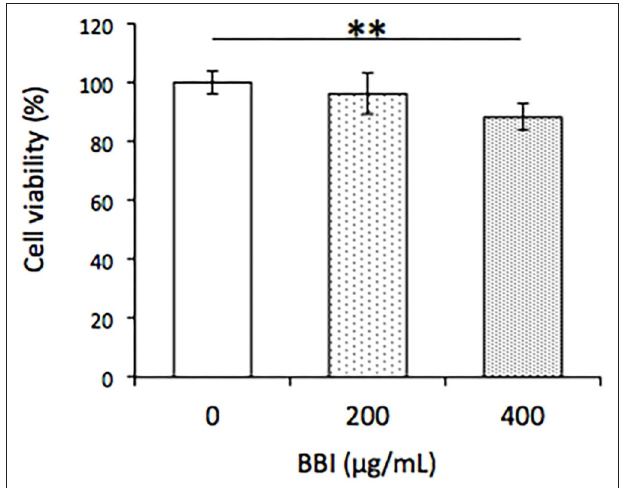
FIGURE 3 | Effect of BBI on cell viability in TLM1 cells. The cells were treated with indicated concentrations of BBI for 5 days. Cell viability was evaluated by a PrestoBlue assay. Columns represent means ± standard deviations ( n = 6). ** p < 0.01 vs. 0 µ g/ml, using Dunnett’s test.